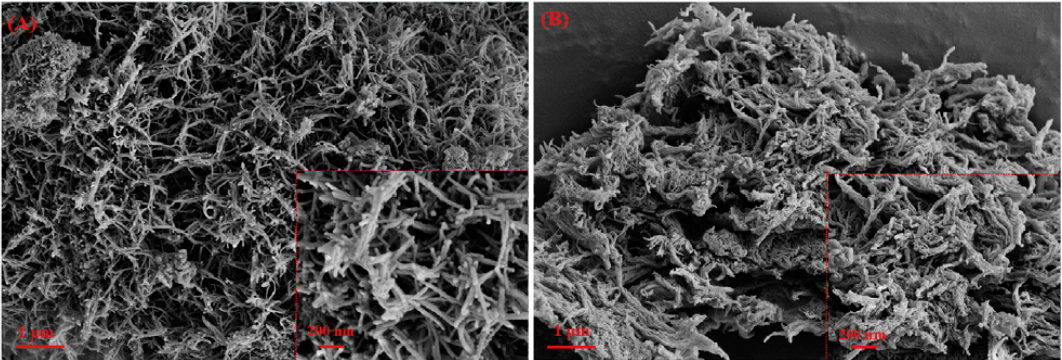
Figure 3. SEM images of MICOFs-7 ( A ) and NICOFs-7 ( B ). Reprinted from [38] with permission of Elsevier.